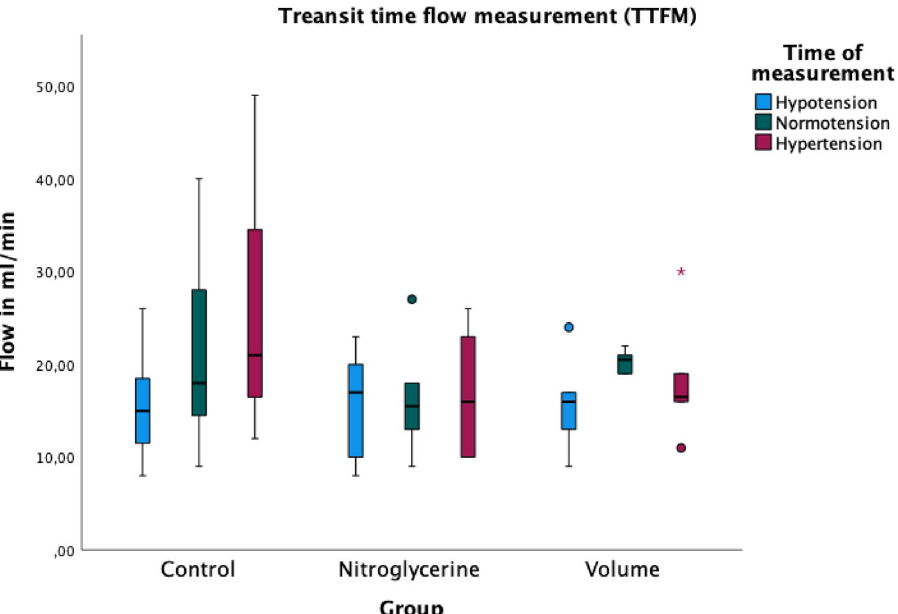
Figure 6. Transit time flow measurement (TTFM) at the right gastroepiploic artery shown as boxplots. Circles (°) represent mild outliers and asterisks (*) represent extreme outliers. The flow is increasing with increasing median arterial blood pressure. The substitution of nitroglycerine is not associated with changes in flow. Hypervolemia shows improved flow at normotension compared to hypo- and hypertension. There were no significant differences between the groups and the time of